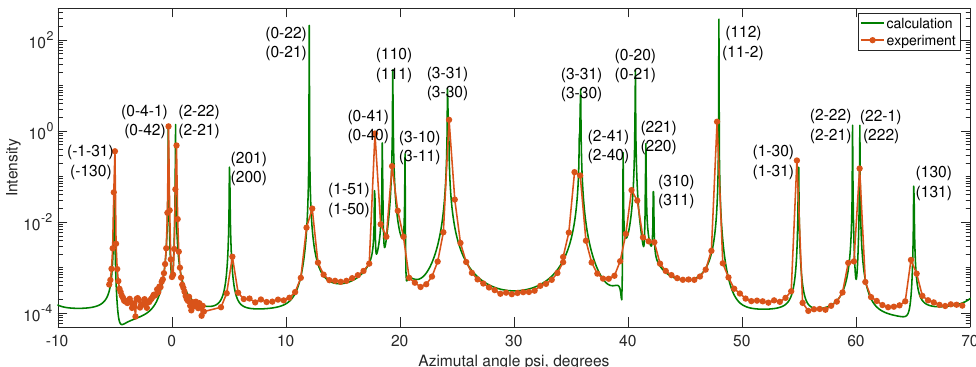
Figure 4. Azimuthal dependence of intensity of three-wave reflections at the photon energy E = 4.5 keV in the geometry of the forbidden reflection (001) in the right α